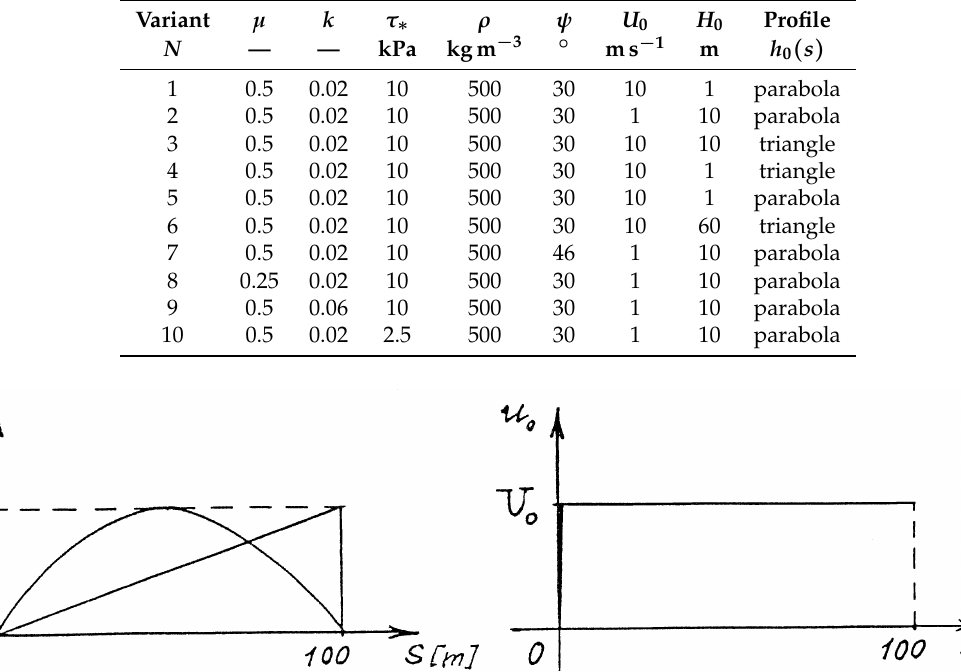
Figure 4. Initial conditions for calculations with the full model: The release depth was chosen either with a parabolic or a triangular longitudinal profile ( left panel ), whereas the initial velocity was assumed uniform ( right panel